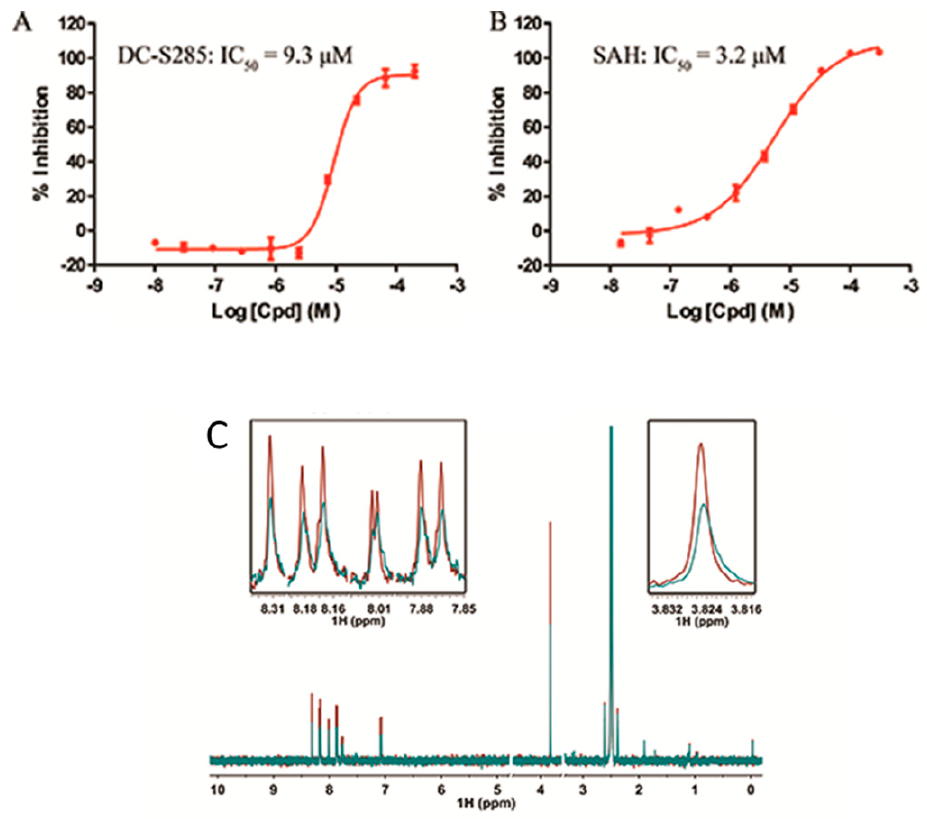
Figure 3. Activity of DC-S285 and of ligand observed 1D NMR experiments. ( A , B ). Inhibitory activities of DC-S285 and its reference compound SAH based on the AlphaLISA assay; ( C ). Carr-Purcell Meiboom-Gill Pulse Sequence reveals that DC-S285 binds to SET7. T1 ρ spectra acquired by using DC-S285 (colored in red), 20 μ M DC-S285 in the presence of 2.5 μ M protein (coloured in blue).